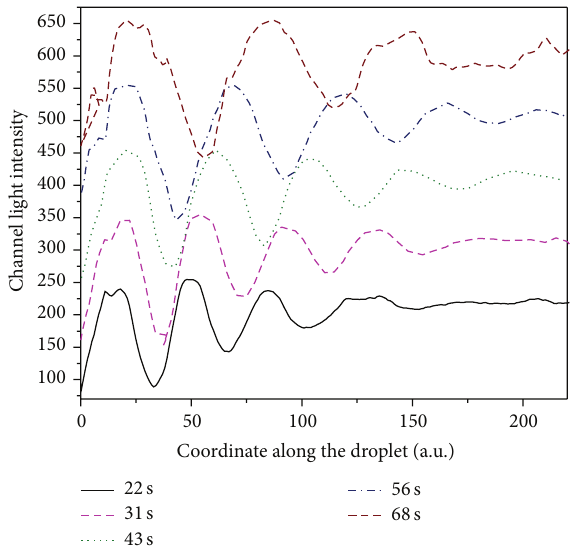
Figure 6: Changes in interference pattern corresponding to red channel after injection of VOC that occurred at ca. 20th s (or 10s after point marked as “Start” in Figure